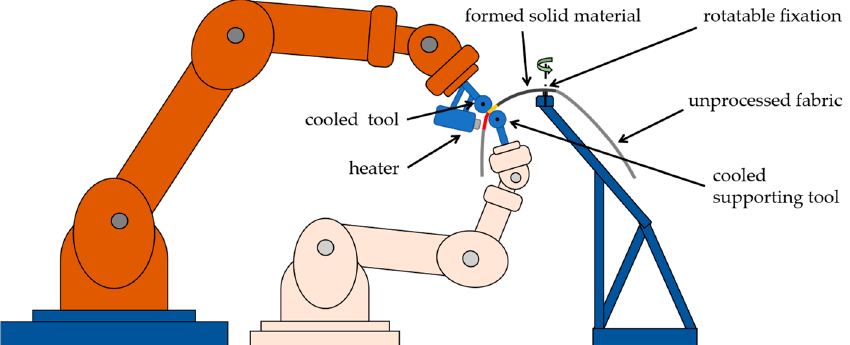
Figure 11. Concept sketch for robotic dieless forming of thermoplastic co-weave [45].